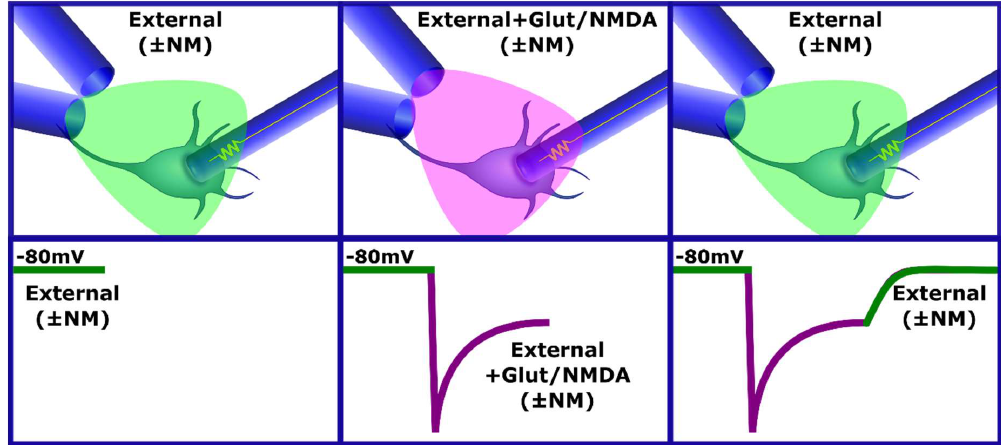
Figure 1. Application of solutions using capillaries. The application of solutions was controlled using solenoid valves; one capillary contained the external solution with or without the tested neuromodulator (External ± NM), and the other had External ± NM and Glutamate or N-methyl–D-aspartate (NMDA) as required. In the bottom panels, there are representative traces of the NMDA-current where the e ff ect of the application of each solution is